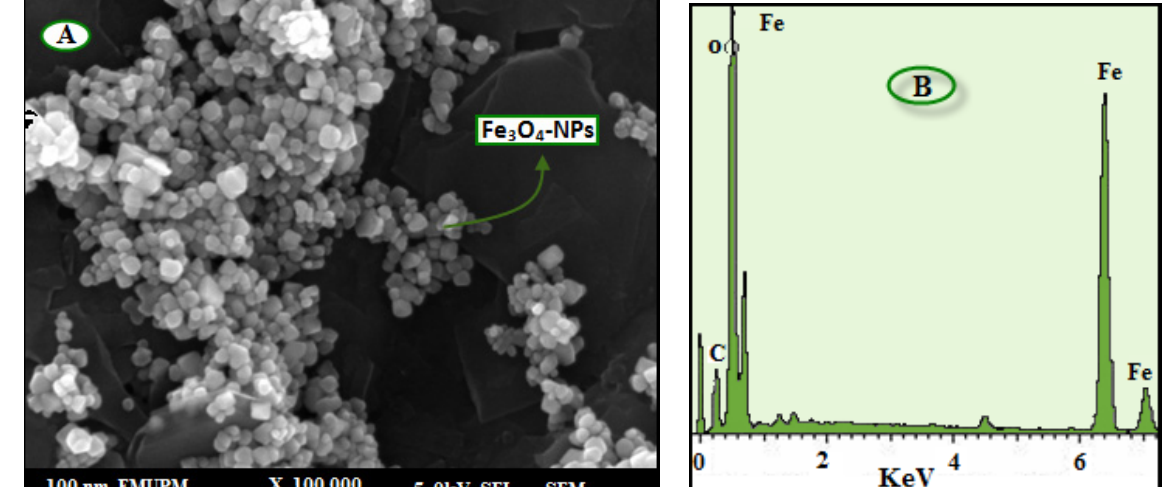
Figure 5. FESEM image ( A ) and energy-dispersive X-ray fluorescence spectrometry O -NPs synthesized using BS extract ( B spectra of Fe 3 4